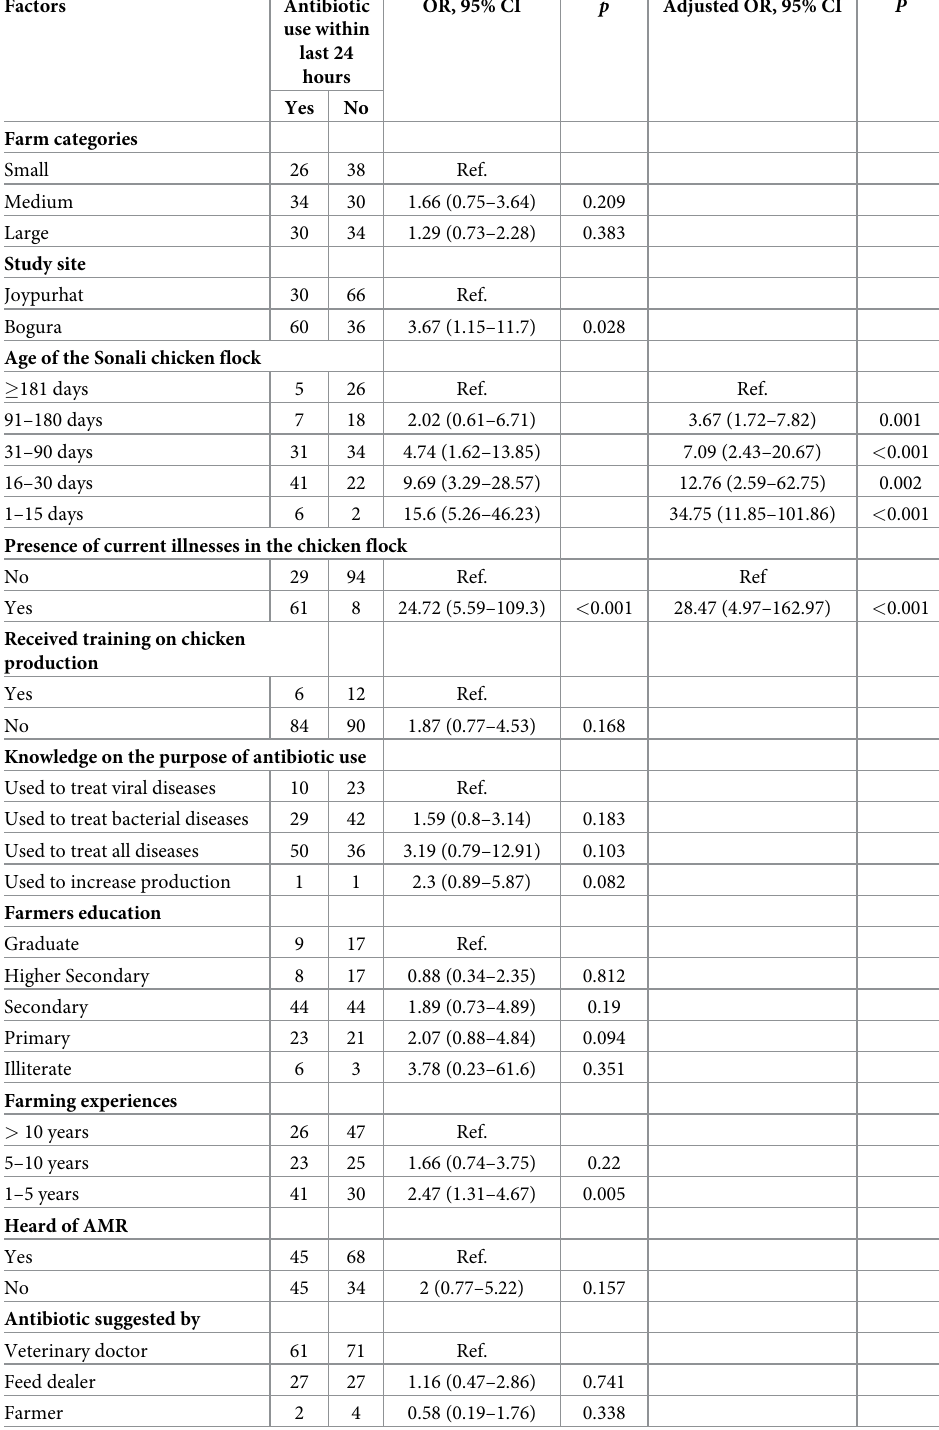
Table 10. Factors associated with antibiotic use in commercial Sonali farms (N = 192), during January-May 2021,